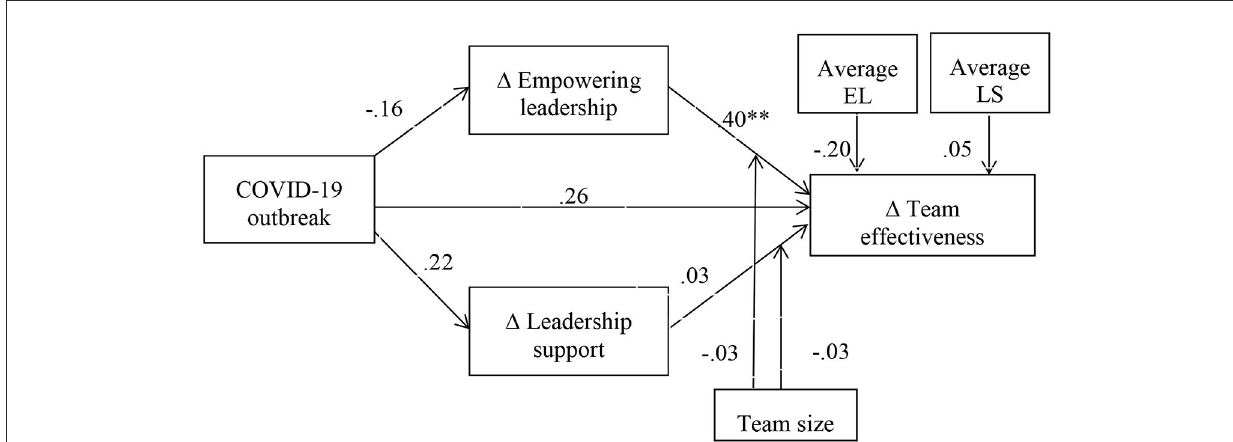
FIGURE4 The overall moderated mediation results for change in team effectiveness as a function of change in empowering leadership and leadership support after the COVID-19 outbreak. ** p < 0.01; EL, empowering leadership; LS, leadership support; 1 empowering leadership, empowering leadership before COVID-19 minus empowering leadership after the COVID-19 outbreak (change in empowering leadership due to COVID-19); 1 leadership support, leadership support before the COVID-19 outbreak minus leadership support after the COVID-19 outbreak (change in leadership support due to COVID-19); 1 team effectiveness, team effectiveness before the COVID-19 outbreak minus team effectiveness after the COVID-19 outbreak (change in team effectiveness due to